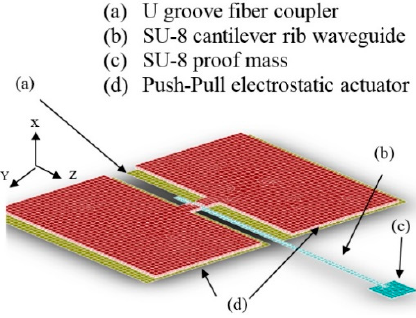
Figure 1. Schematic of the electrostatic MEMS scanner.